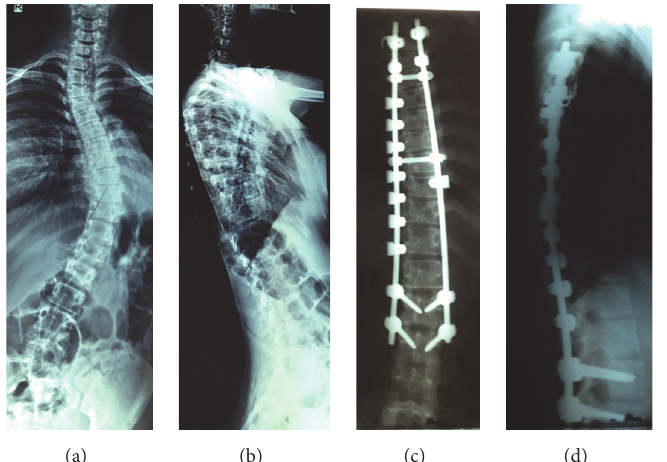
Figure 2: (a) and (b) A 16-year-old girl with AIS without brace treatment. (c) and (d) After correction, PSF and instrumentation by hybrid UC technique.